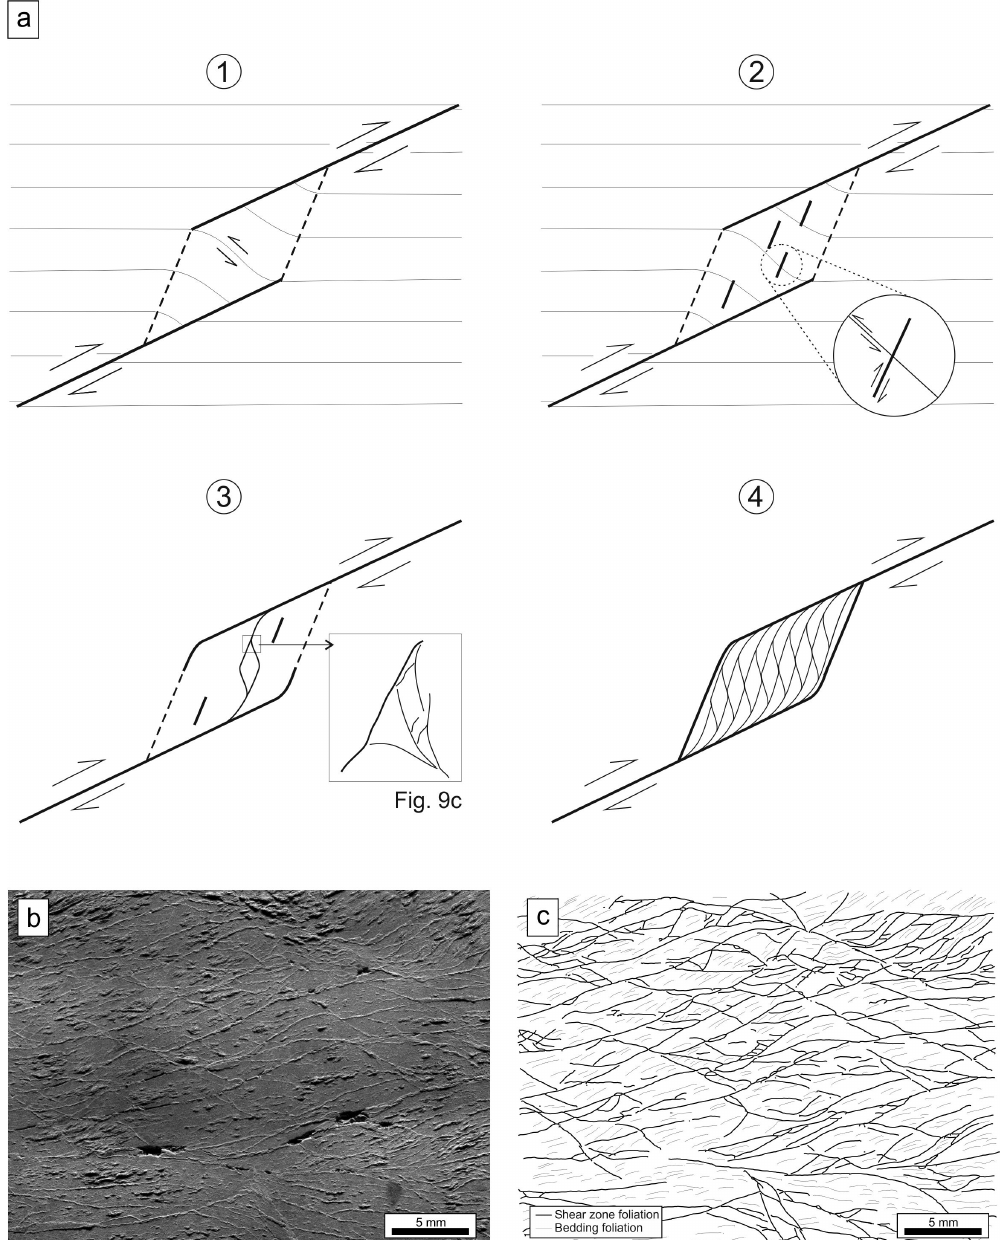
Figure 16. (a) is a simplified mechanical model of the progressive development of anastomosing shear zones. (1) Initial contractional relay (after Nicol et al., 2002) and relay internal development of a kink band by reorientation of bedding (compare to Fig. 14). (2) Development of relay internal R-hears that themselves link as relays (3). The inset compares to shear zones shown in Fig. 9c. (4) Progressive development and linking of further shears. (b) is an inset and (c) a sketch from Fig. 12. Note the similar shear zone patterns of (4) and (c)